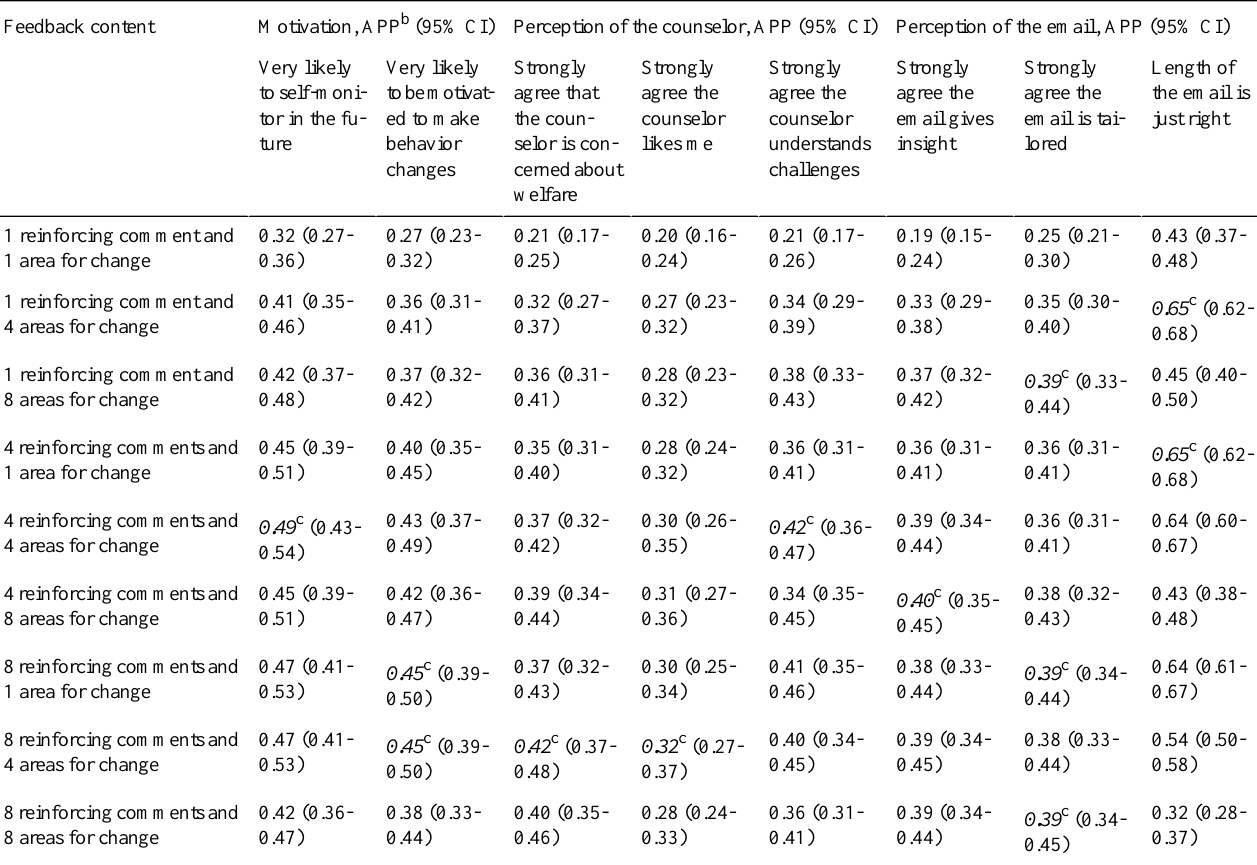
Table 3. Average predicted probabilities of combinations of email feedback on all outcome measures (N=250).